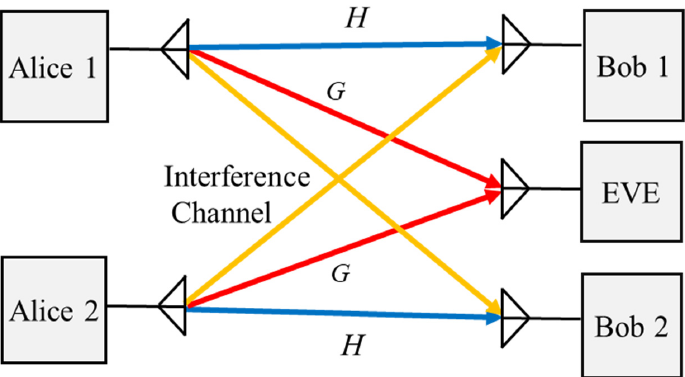
Figure 5. Secure communication using an interference channel model.